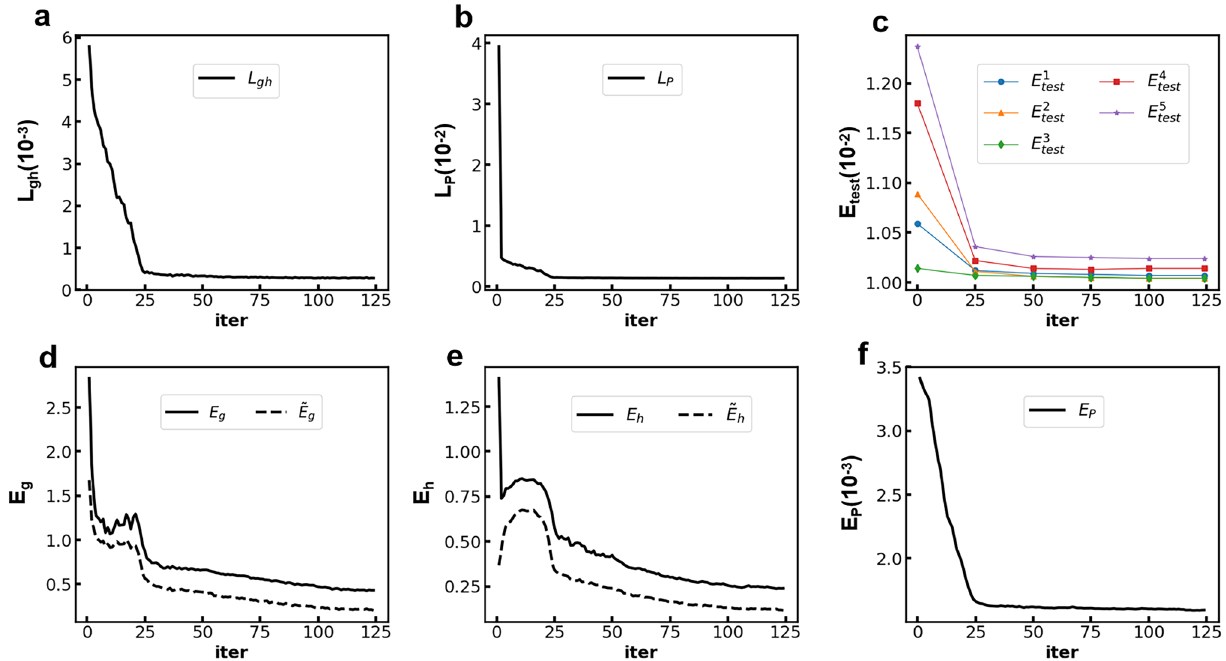
Figure 3. Curves of a typical training process with the data of the agents’ wealth. The training is stopped when the sum of L gh and L P fails to decrease within 20 successive iterations. ( a ) L gh . ( b ) L P . ( c ) E test . (d) E g (solid line) and ˜ E g (dash line). ( e ) E h (solid line) and ˜ E h (dash line). ( f ) E P .